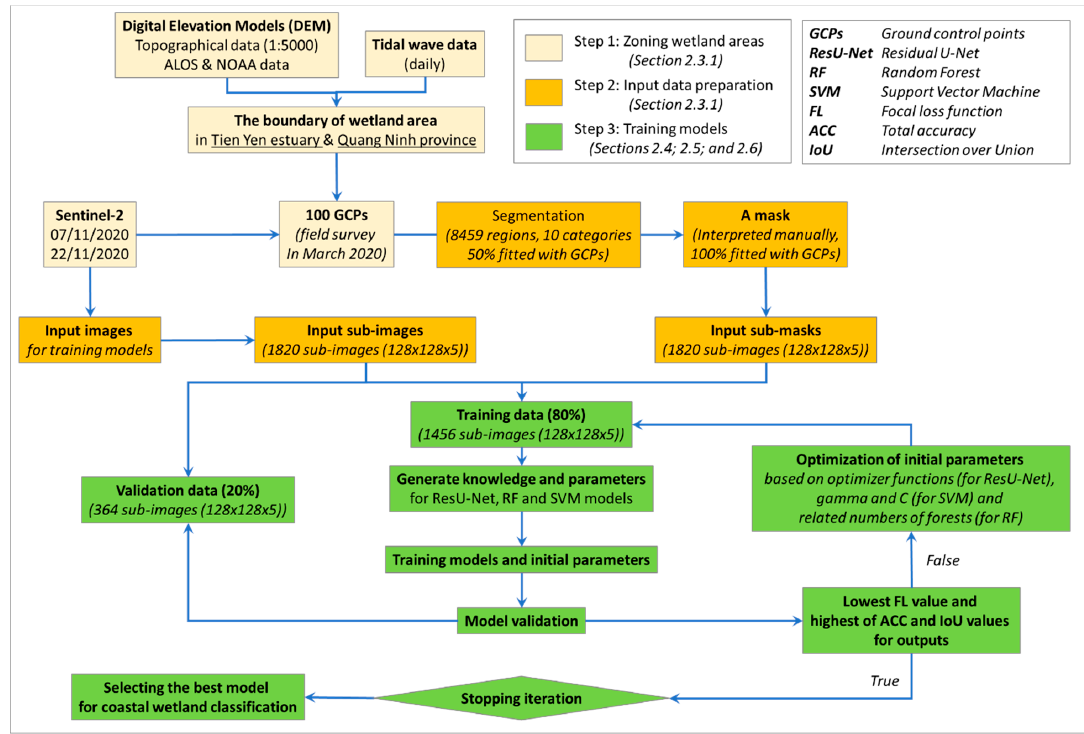
Figure 2. The structure of the deep learning model development for coastal wetland classification.